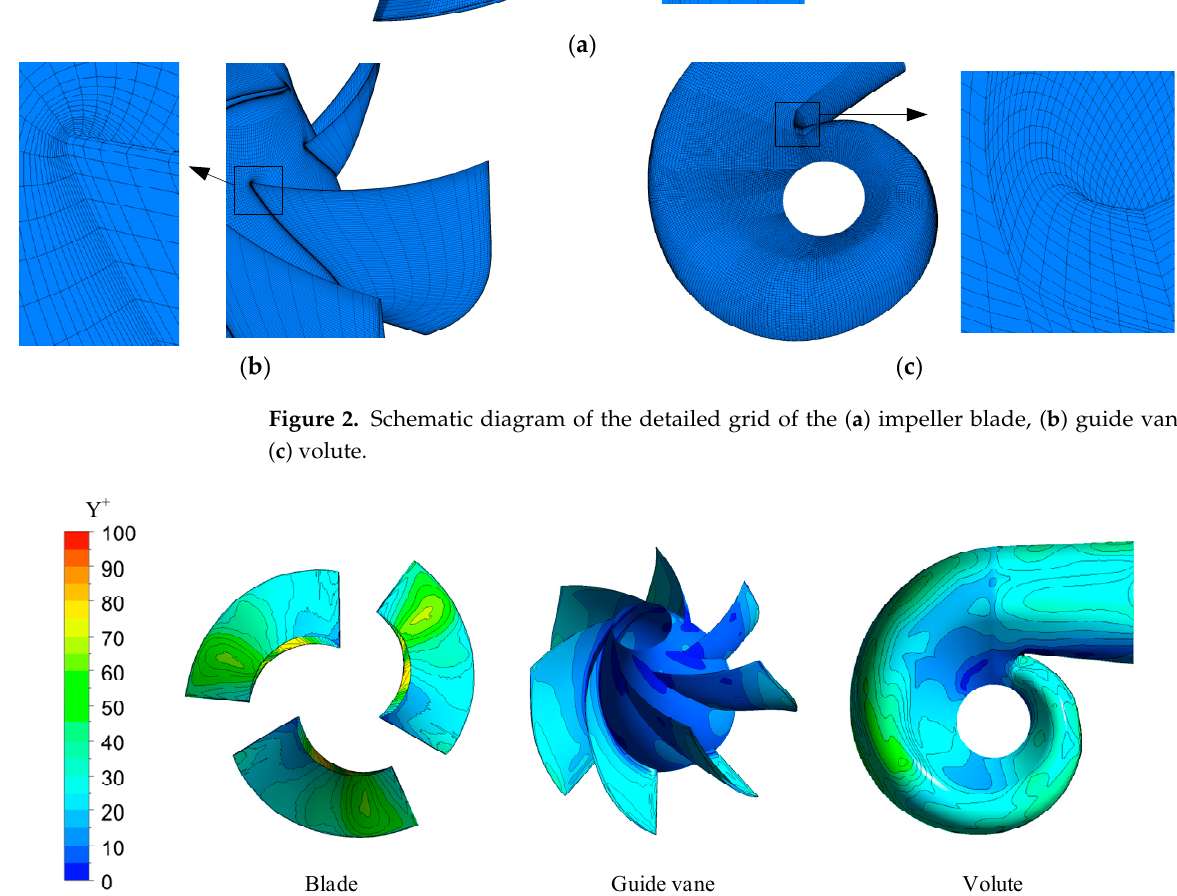
Figure 3. Y+ value of each component.